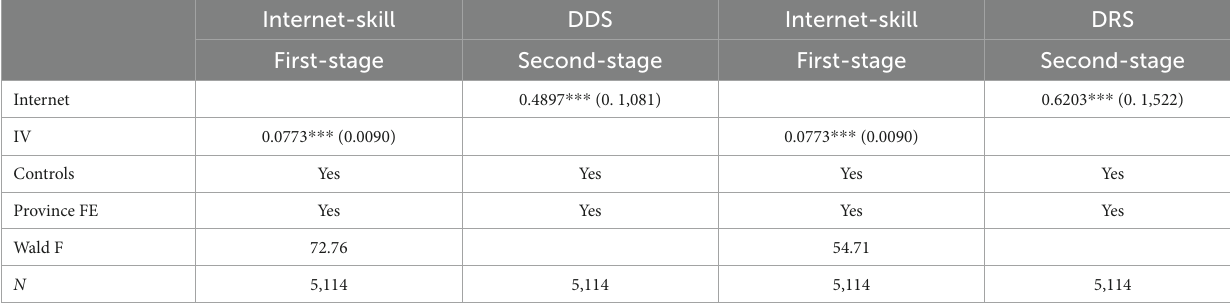
TABLE 3 Results of a 2-stage instrumental variable regression of the impact of Internet use on farm households’ diets.